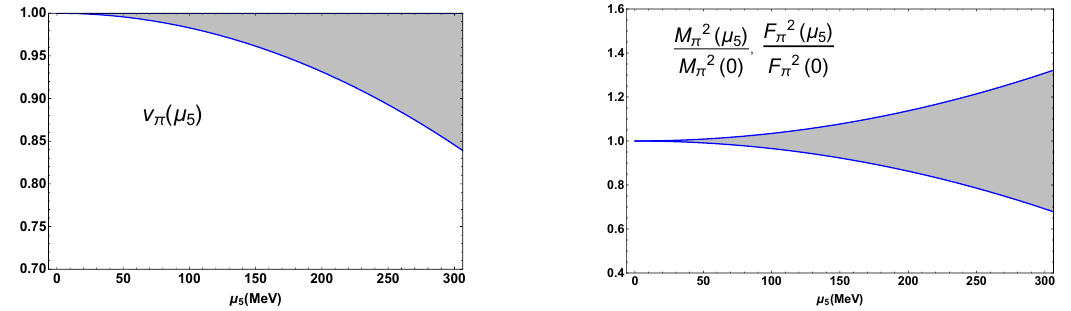
Figure 1 . (cid:22) 5 dependence of pion velocity, pion mass and pion decay constant, to leading order in ChPT. The grey bands correspond to the uncertainties of the LEC within natural values, namely 0 (cid:20) (cid:20) 2 (cid:20)